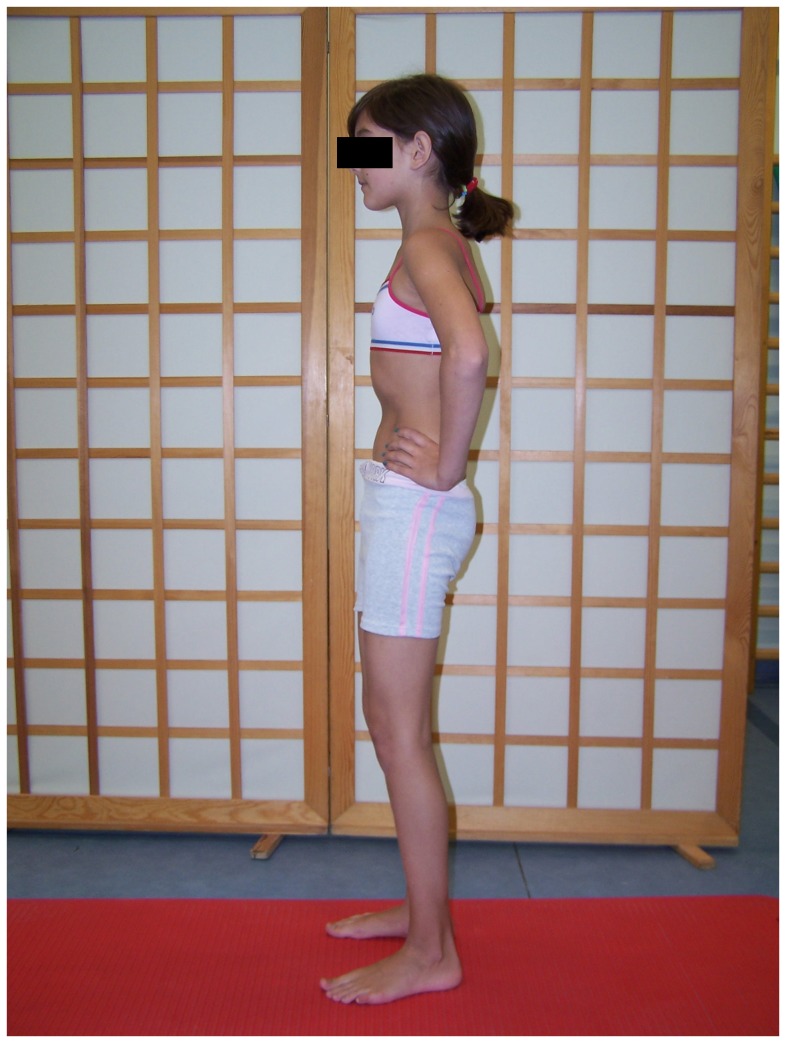
Gluteus maximus activation in a standing position.